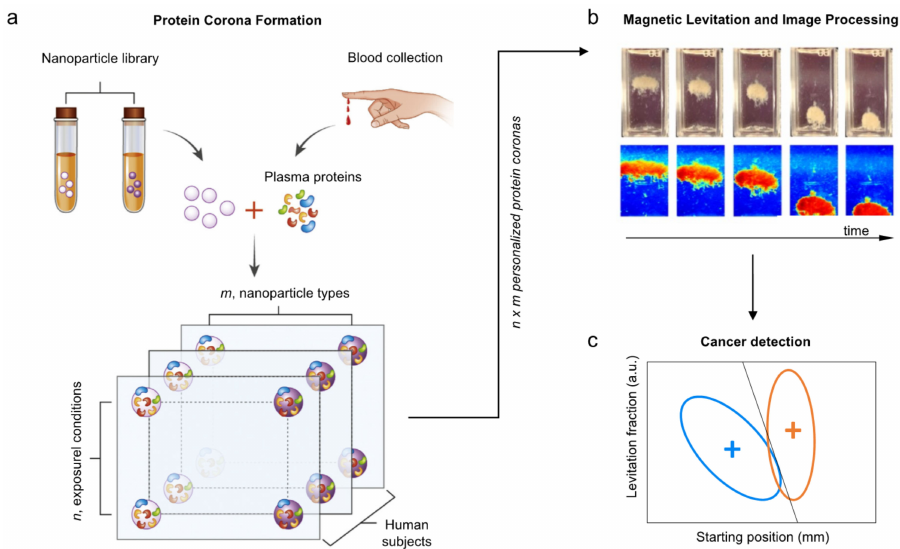
Figure 5. Optimization of the MagLev NEB test for cancer detection. ( a ) For a given cancer type, a library of m nanoparticle types is exposed to plasma proteins from patients with and without the condition under n different exposure conditions (e.g., protein concentration, incubation time, shear stress, etc.). ( b ) Each library component is introduced in the MagLev device and the levitation profile is followed in time. Image processing allows for the identification of a set of MagLev fingerprints for cancer (e.g., starting position of the nanoparticle–protein corona, the relative abundance of the levitating fraction, etc.). ( c ) Research is aimed at identifying one of the ( m × n ) library components that maximize sensitivity and the specificity of the MagLev NEB test. (Adapted from ref. [36]).